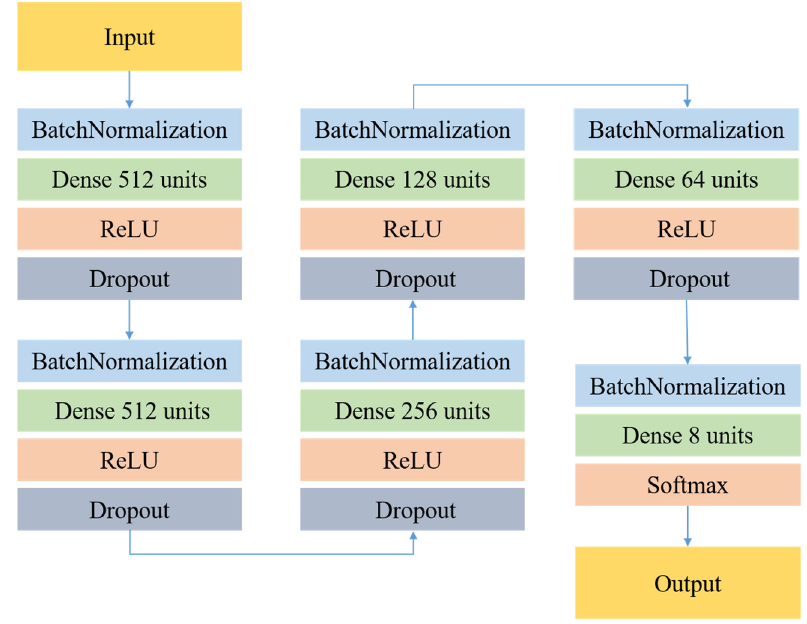
Figure 4. The proposed Deep Neural Network Model.